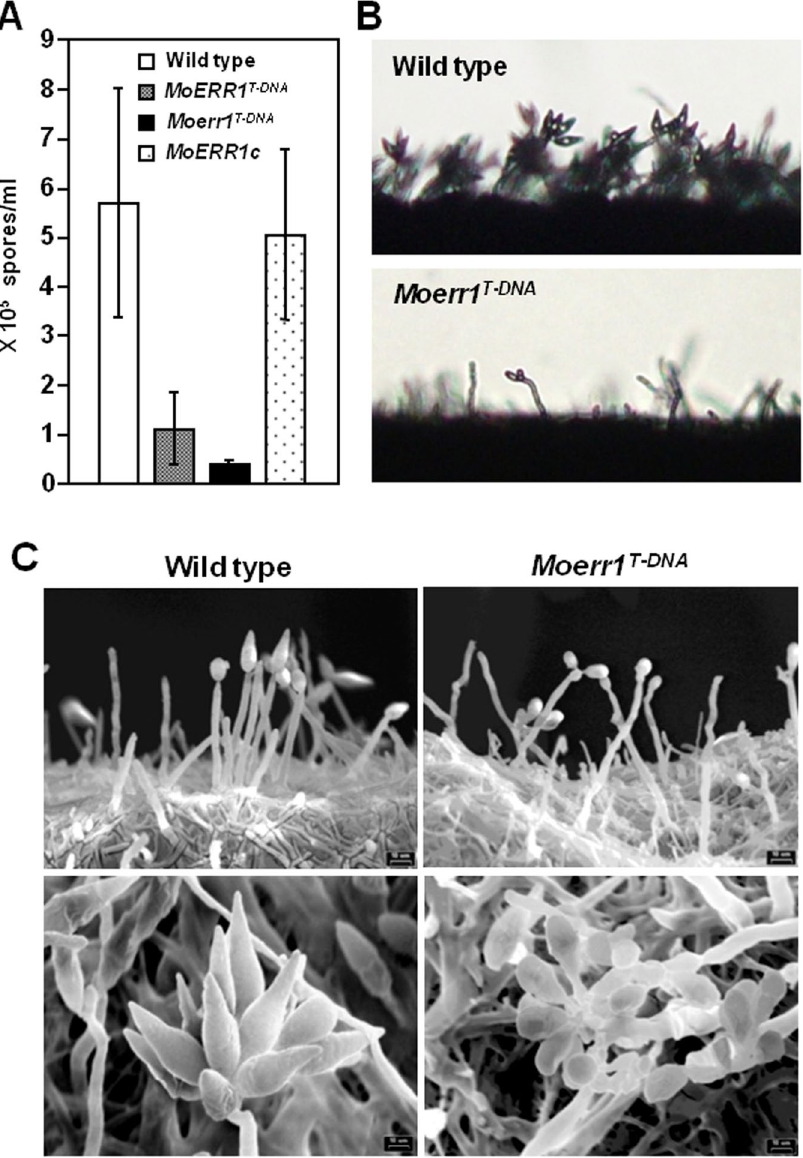
Figure 4. Conidiation and conidiophore development. ( A ) Conidiation was quantified at 10 dpi on oatmeal agar. The values are the means with SD of three replicates. ( B ) Conidiophore development was observed under light microscope at 18 hpi. ( C ) Conidiophore was examined by scanning electron microscopy. Magnification of upper panel was x750 and that of lower panel was